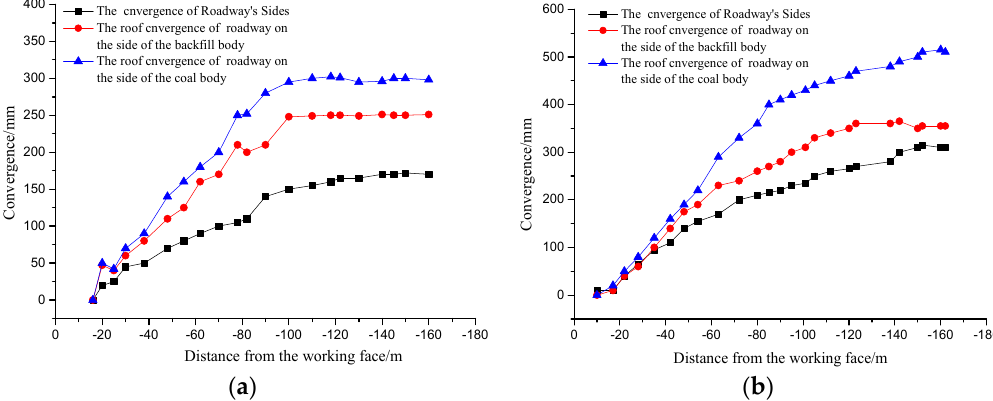
Figure 14. The deformation of the gob-side retaining entries for the 72207 and the 72201 working faces: ( a ) the amount of surrounding rock moving in the 72207 working face rail roadway; ( b ) the amount of surrounding rock moving in the 72201 working face rail roadway.